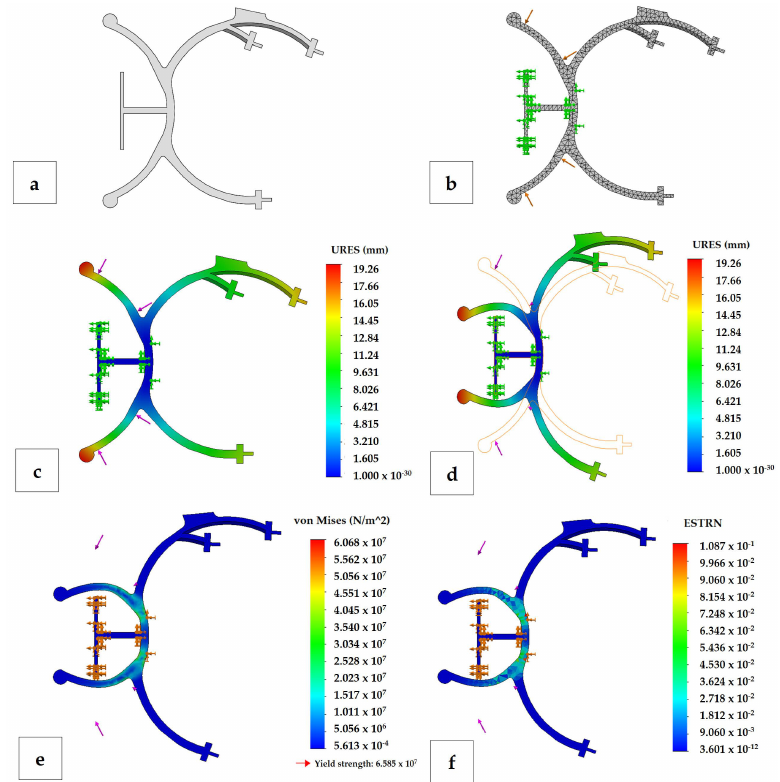
Figure 2. Some steps of FEM simulation of the TPU compliant mechanism at 35 N applied force: ( a )-geometry model designing; ( b )-fixing geometry, applying force and meshing; ( c )-displacement results (undeformed model); ( d )-displacement results (deformed model); ( e )-Von Mises stress results; ( f )-strain results (the arrows represent the mode of action of the force).